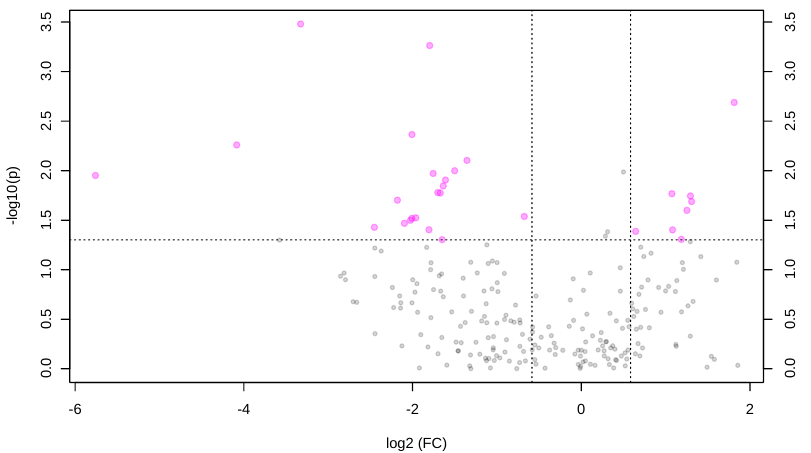
Figure 4. Volcano plot of the effect of obesity on salivary metabolites. Pink dots represent metabolites with significant differences and gray dots represent metabolites with no significant differences. The pink dots on the left represent metabolites above the thresholds whose concentrations were increased, while the pink dots on the right represent metabolites whose concentrations are decreased. The x -axis corresponds to log2 (fold change) and the y -axis to − log10 ( p -value).